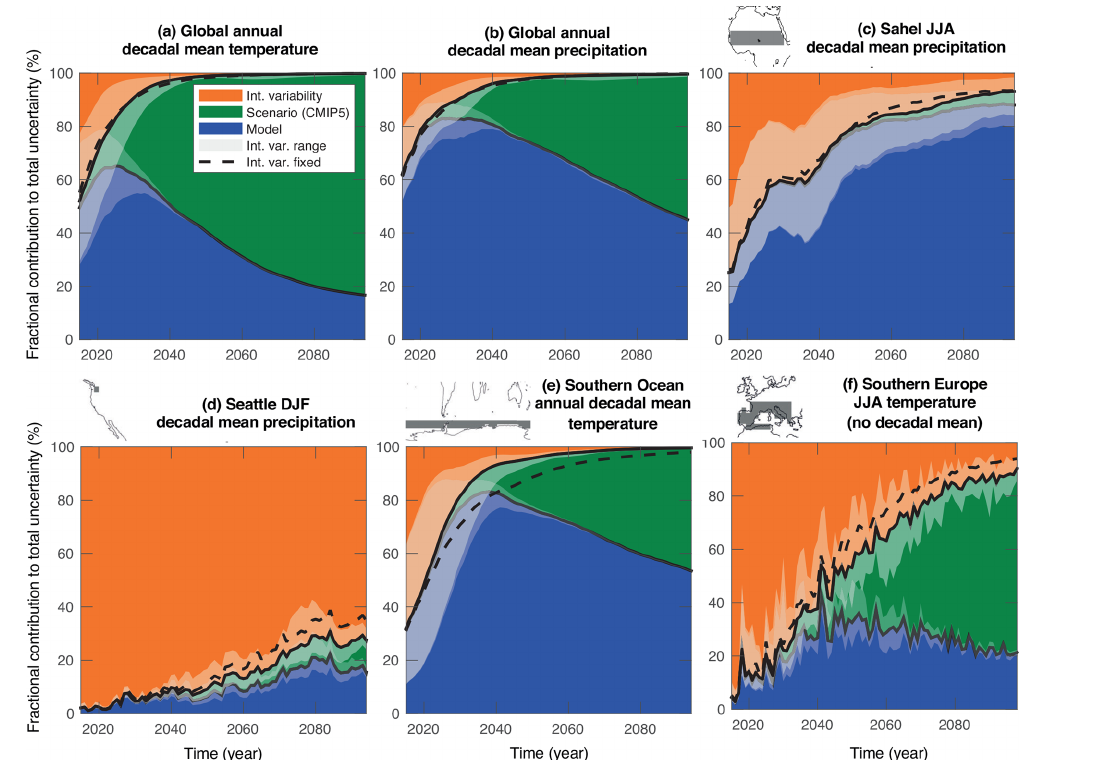
Figure 7. Sources of uncertainty from SMILEs (using scenario uncertainty from CMIP5) for different regions, seasons and variables. The solid black lines indicate the borders between sources of uncertainty; the slightly transparent white shading around those lines is the range of this estimate based on different SMILEs. The dashed line marks the dividing line if internal variability is assumed to stay fixed at its 1950–2014 multi-SMILE mean. All panels are for decadal mean projections, except (f) southern Europe June–August temperature, to which no decadal mean has been